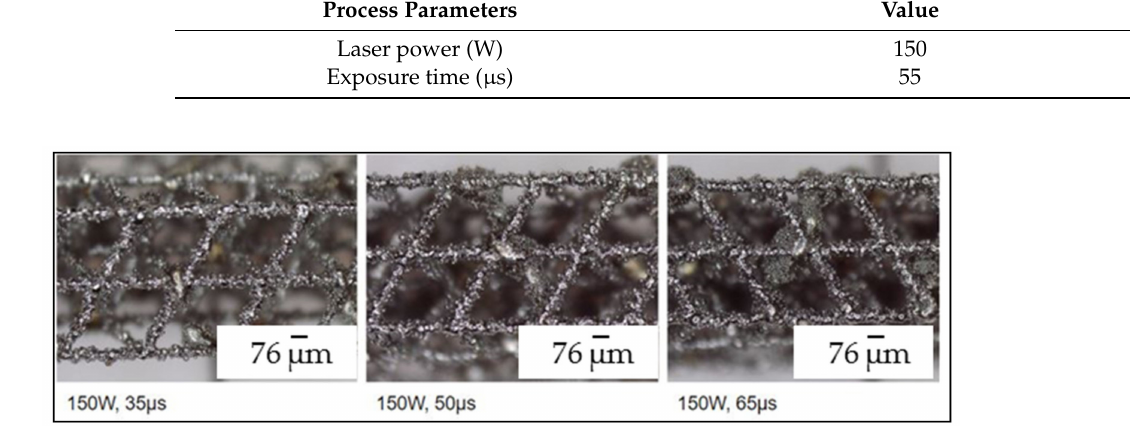
Figure 4. Printed workpieces. ( Left ) Microstructure printed with 150 W laser power and 35 µ s of exposure time. ( Center ) Microstructure printed with 150 W laser power and 50 µ s of exposure time. ( Right ) Microstructure printed with 150 W laser power and 65 µ s of exposure time.